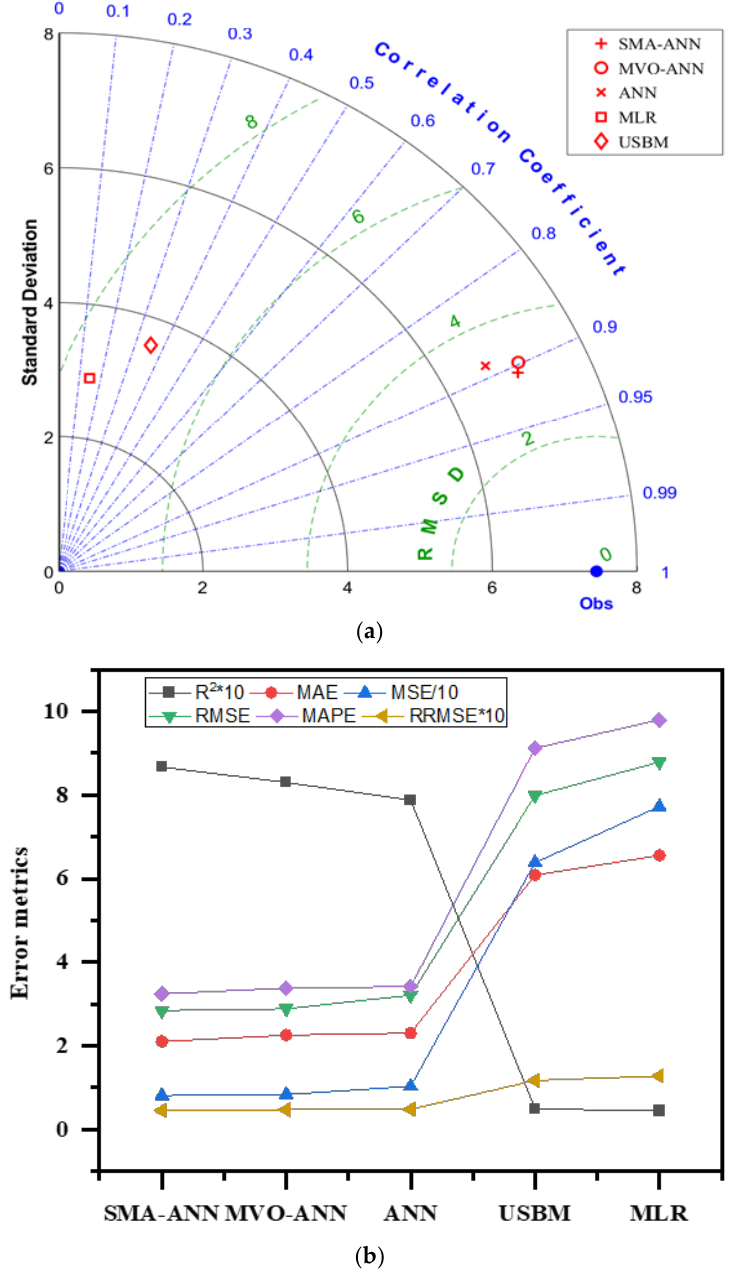
Figure 9. Comparison of the developed AOp models by means of ( a ) a Taylor diagram; ( b ) six error metrics.